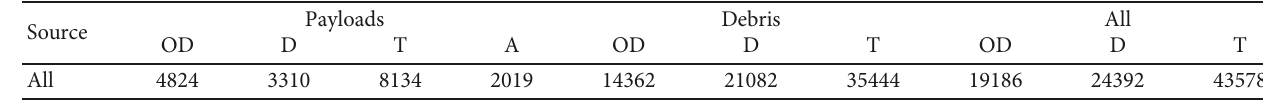
Table 1: Orbital population till July 26,